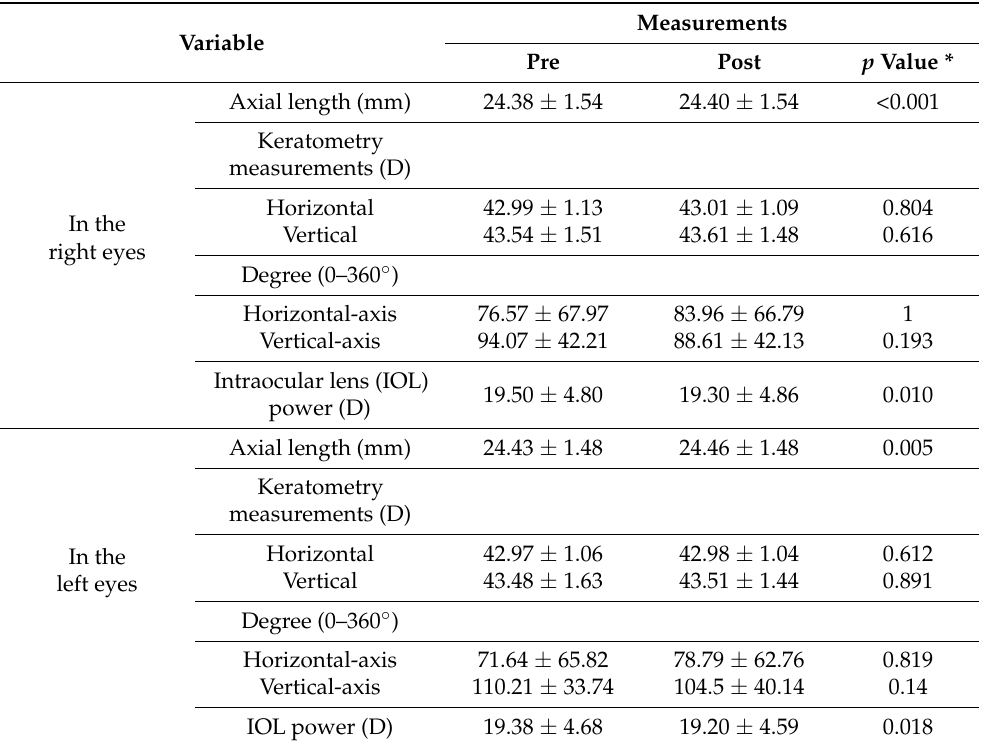
Table 3. Comparison of axial length and keratometry measurements between pre- and post- methimazole treatment of Graves’ disease